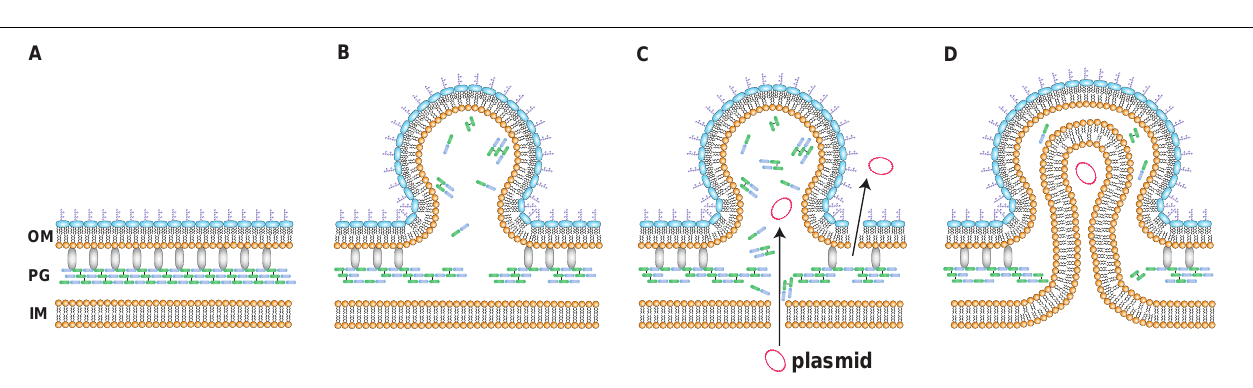
FIGURE 8 | A possible model for DNA incorporation into vesicles. (A) The spatial image of the surface of Escherichia coli . Peptidoglycan (PG) is localized between the outer membrane (OM) and the inner membrane (IM). Braun’s lipoprotein Lpp (gray) forms crosslinks between OM and PG. (B) Defects in PG increase outer membrane vesicle (OMV) formation. The depletion of NlpI or the addition of glycine causes defects in peptide crosslinks in PG. The loss of bridges between OM and PG and the accumulation of PG fragments increase OM curvature, ultimately resulting in OMV formation. (C,D) Mechanisms for the incorporation of plasmids into OMVs in E. coli cells after exposure to glycine are explained by two proposal models. One is the leakage of plasmids (C) . The membrane permeabilities of both OM and IM are increased when PG is not synthesized normally. The other mechanism is the formation of outer-inner membrane vesicles (O-IMVs) (D) . IM and cytoplasmic components such as plasmids are included in the vesicle that is leaving the cell. The encapsulation of IM is considered to occur at the site where peptidoglycan is not normally synthesized.